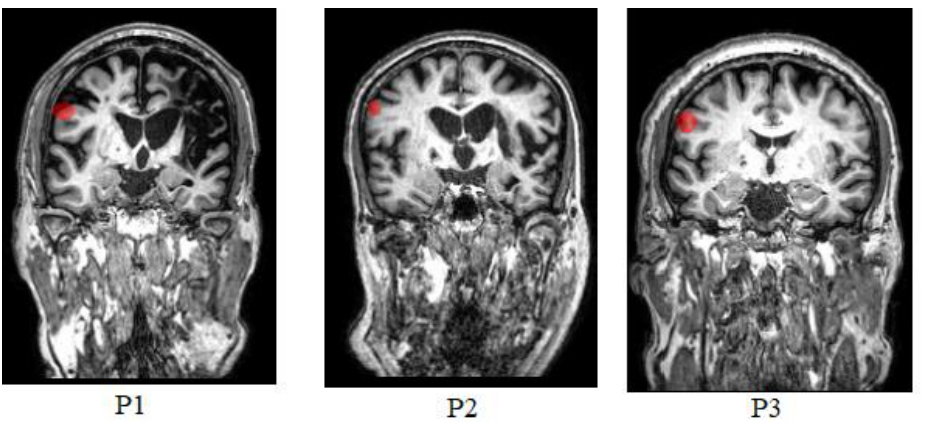
Figure 2. A coronal view of the structural 3D data obtained at the pretest for the three participants. ROIs corresponding to the seed for functional connectivity are shown in red.